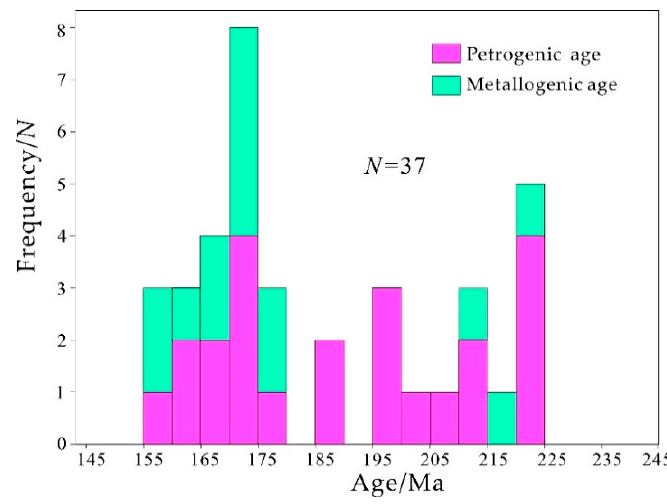
Figure 11. Histogram of petrogenic ages of granitic rocks in the Jidong gold province. Table 11. The petrogenetic and ore-forming age in the Jidong gold province.